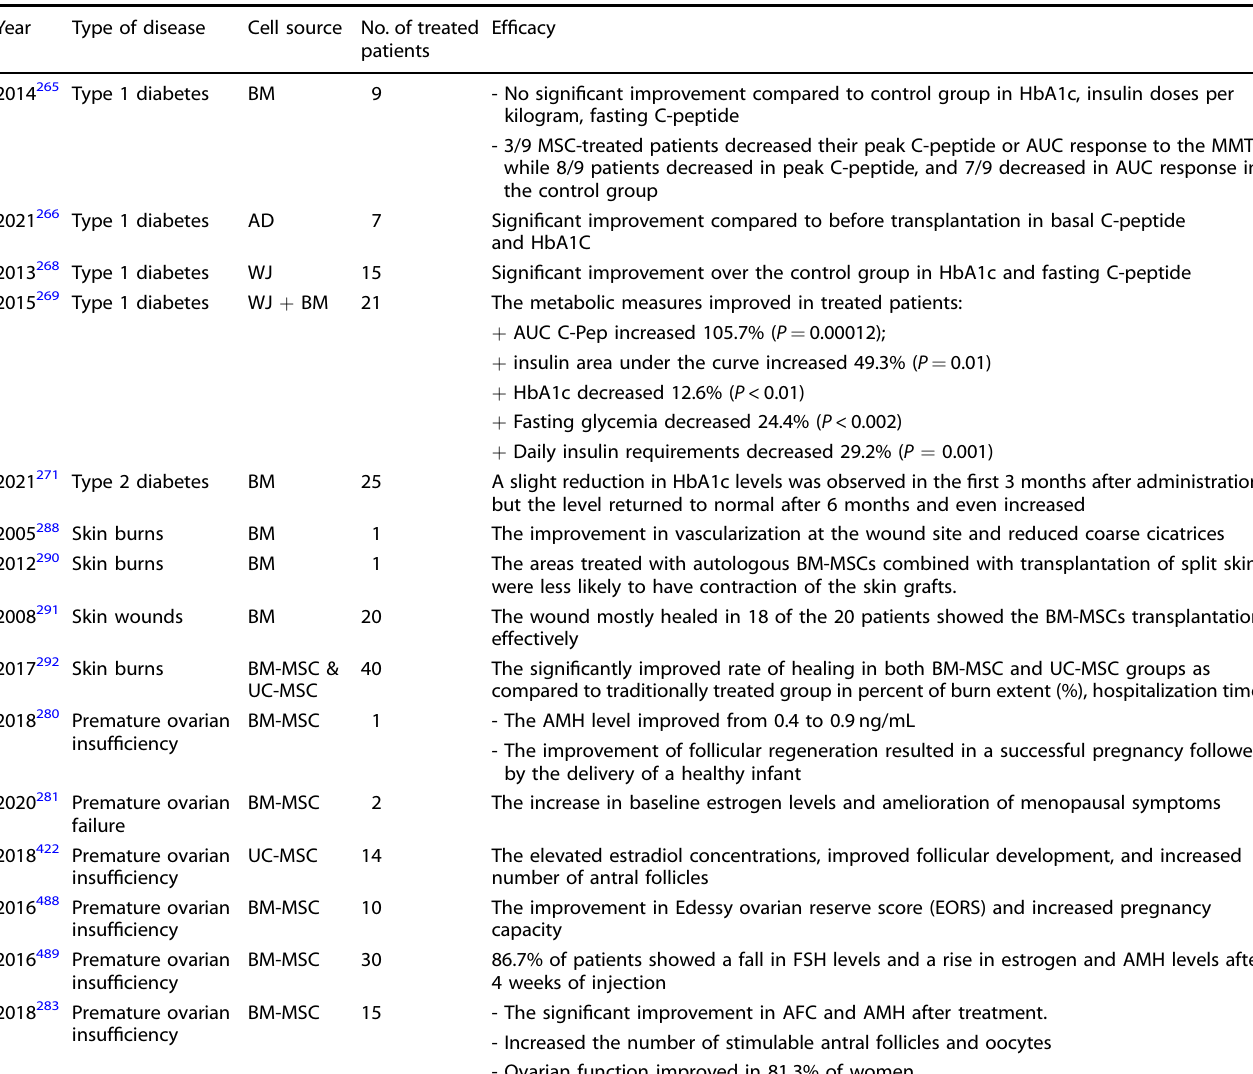
Table 3. The reported clinical trials using MSCs from AT, BM, and UC in the treatment of the endocrinological disorder, reproductive disease, and skin